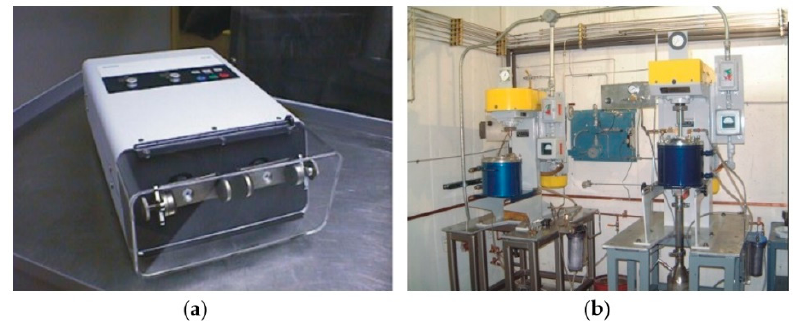
Figure 9. Images of ( a ) a shaker mill (Spex, Metuchen, NJ, USA) and ( b ) an attritor used in MA processes (Union Process, Akron, OH, USA).